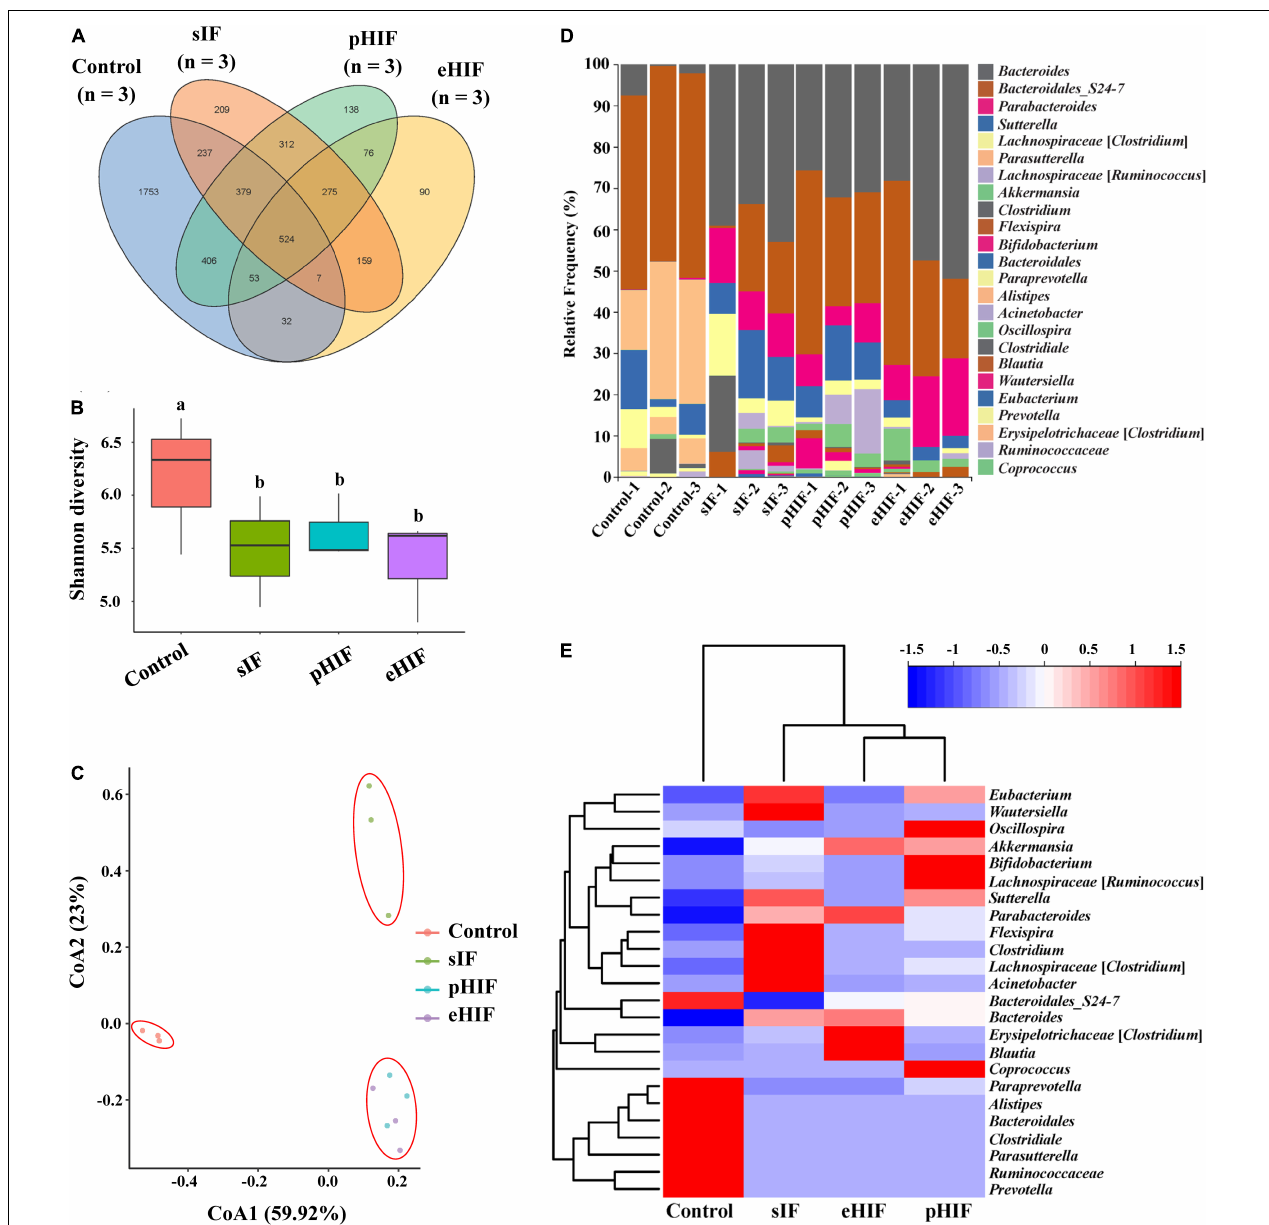
FIGURE 6 | Composition of the fecal microbiota of mice, n = 3 independent experiments. (A) Venn diagram of ASVs in the fecal microbiota from the mice after the 30-day experiment. (B) Cluster analysis of the four treatment groups based on ASVs. (C) The correlation of ASVs among the four groups. (D) Taxonomic complexity of the bacterial community. (E) Heatmap of the abundance of all